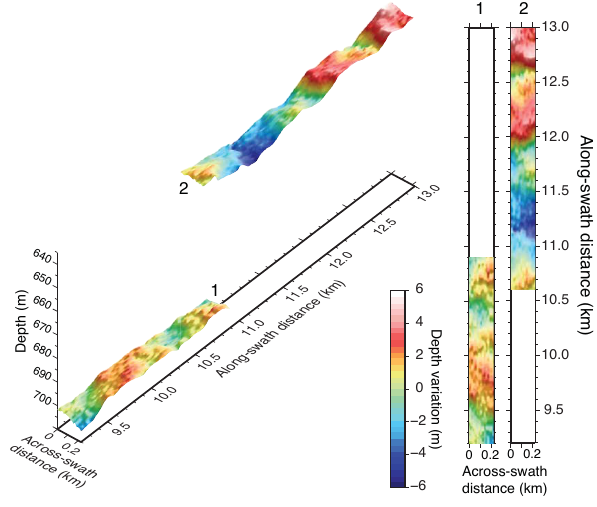
Fig. 6. Reflections 1 and 2, tracked in Fig. 5, are shown in 3-D perspective view (left) and 2-D map view